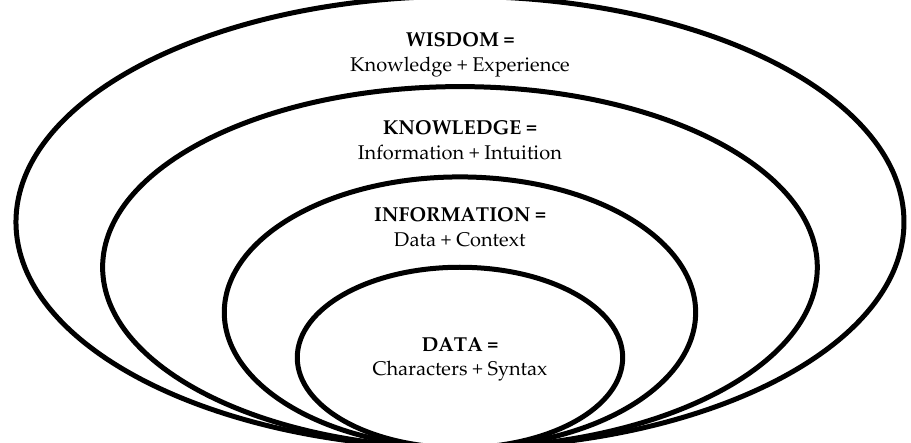
Figure 1. Dependencies occurring on the data–information–knowledge–wisdom line. Source: own study based on (Rowley 2007).